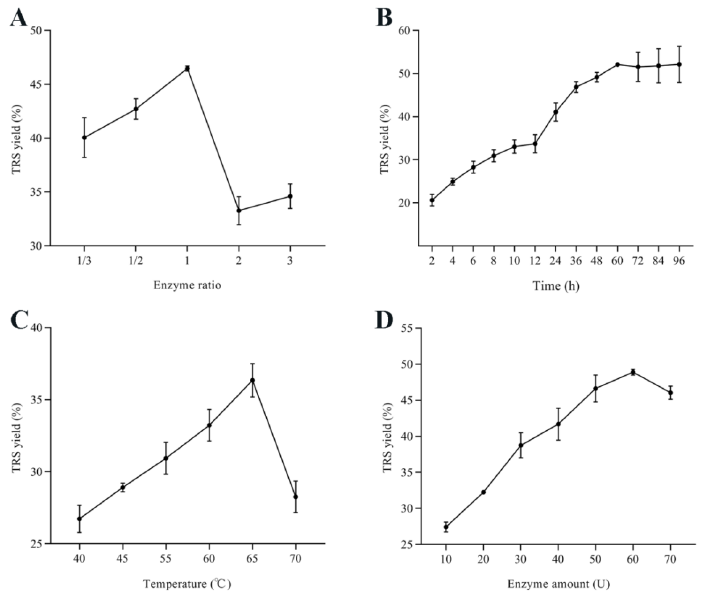
Figure 3. Effects of enzymatic hydrolysis parameters on TRS yield. Panels ( A – D ) show the effects of enzyme ratio, reaction time, temperature, and enzyme amount on TRS yield, respectively. Table 4. Observed responses in the Box–Behnken design for enzymatic hydrolysis.